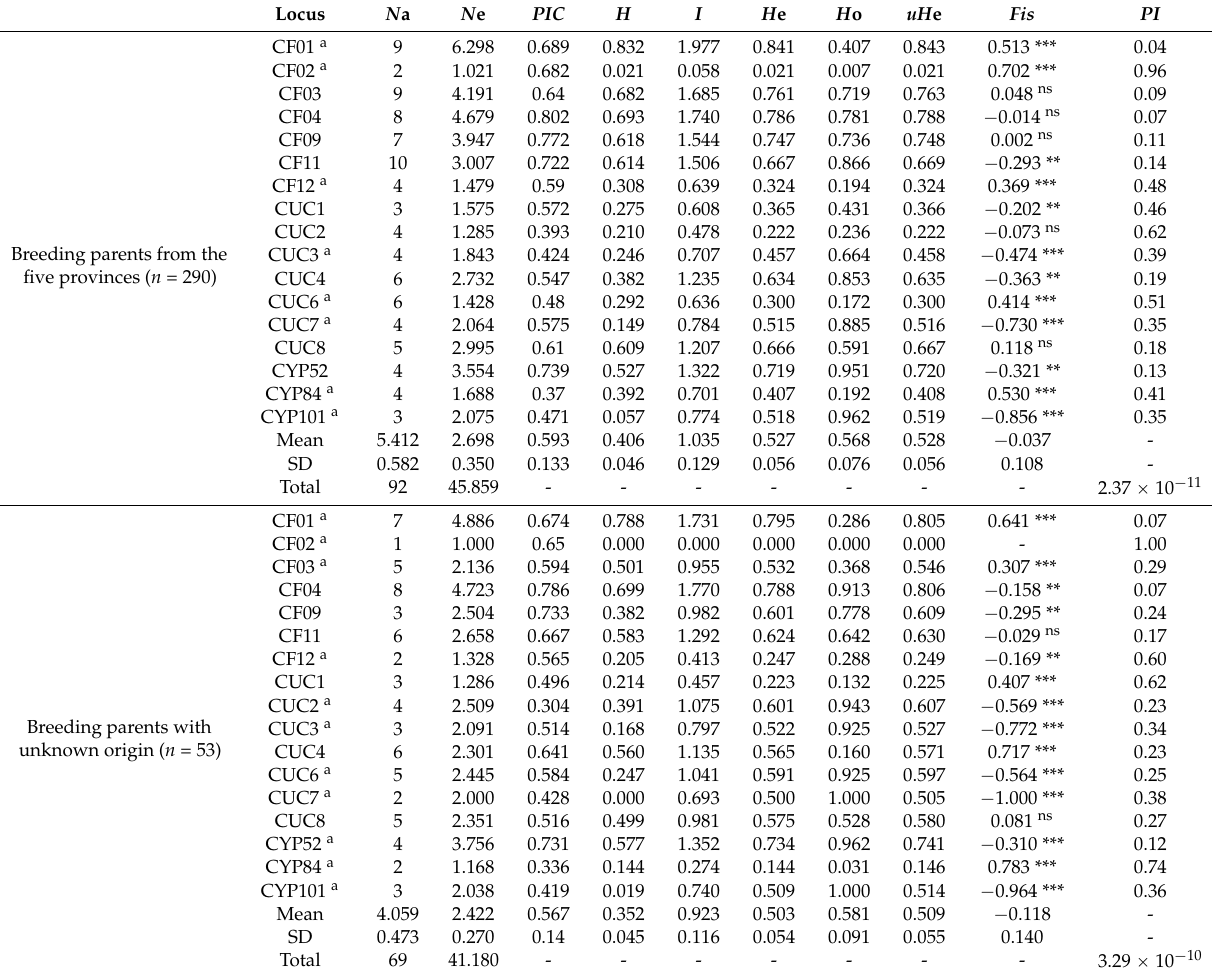
Table 2. Genetic diversity for 17 microsatellite loci analyzed in breeding